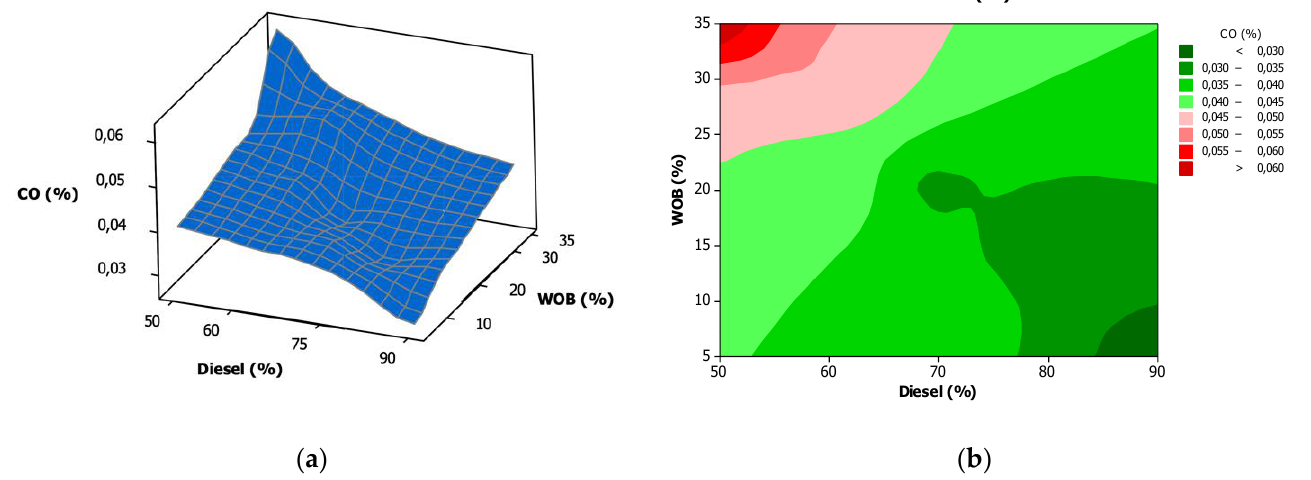
Figure 5. ( a ) Surface plot; ( b ) contour plot of CO emission with input variables.